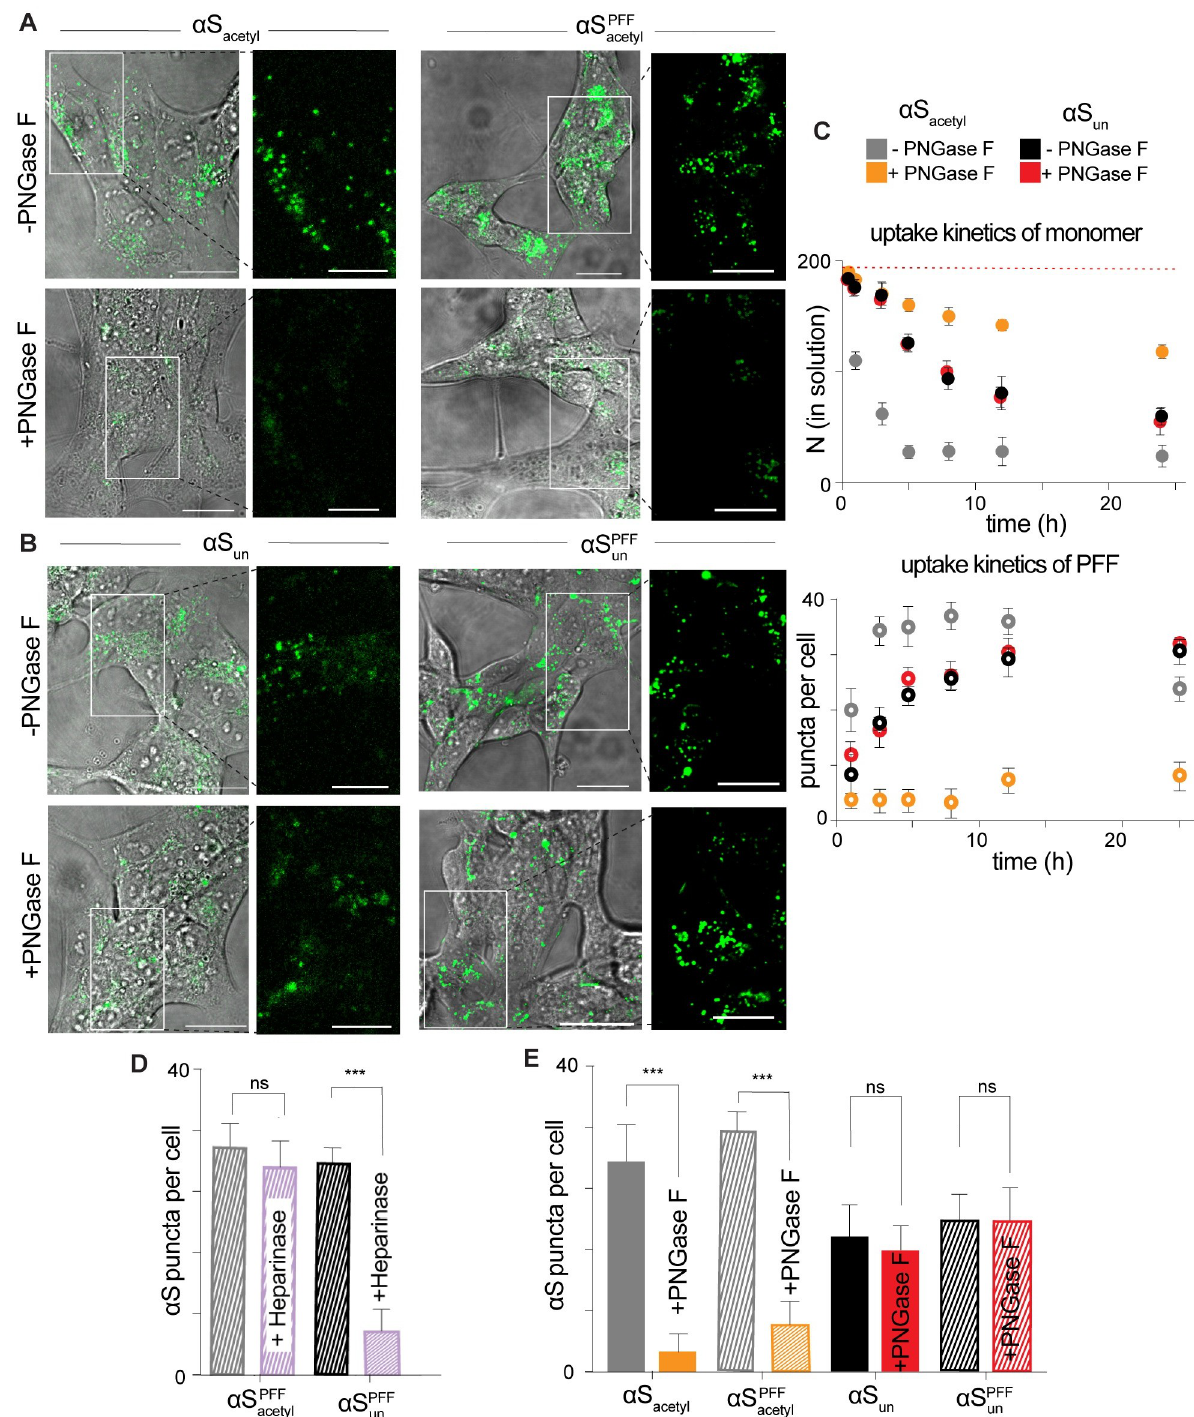
Fig 2. Complex N-linked glycans selectively enhance uptake of α S acetyl by SH-SY5Y cells. (A) Representative images of SH-SY5Y cells following 12-hour incubation with monomer or PFF α S acetyl -AL488, − /+ PNGase F treatment. (B) As in (A) but for monomer or PFF α S un -AL488. (C) Upper: kinetics of internalization by SH-SY5Y cells of monomer α S as quantified by loss from extracellular medium by FCS, − /+ PNGase F treatment. Lower: kinetics of internalization by SH-SY5Y cells of PFF α S as quantified by puncta analysis of confocal images, − /+ PNGase F treatment. (D) Quantification of internalization of α S PFFs by SH-SY5Y cells, − /+ Heparinase I/III treatment. Images collected following 12-hour incubation with protein and quantified by puncta analysis. (E) Quantification of internalization of α S monomer and PFF by SH-SY5Y cells, − /+ PNGase F treatment.